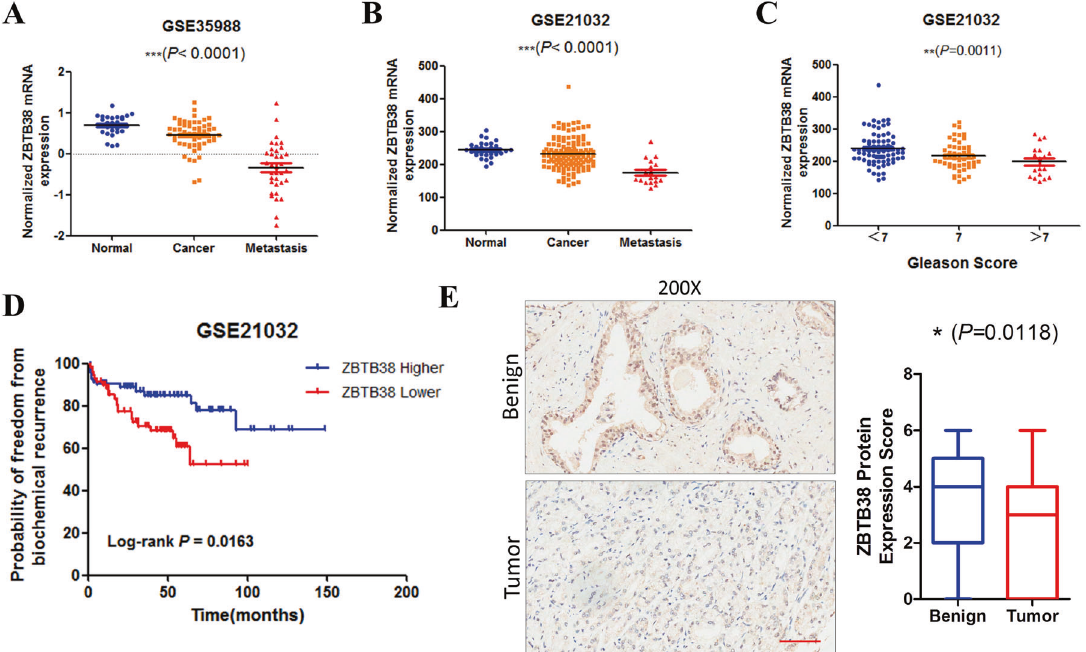
Fig. 1 ZBTB38 expression level correlates with prostate cancer progression and prognosis. A , B ZBTB38 mRNA expression levels in prostate cancer samples from GSE35988 ( A ) and GSE21032 ( B ). One-way ANOVA analysis was used. C ZBTB38 mRNA expression levels in prostate cancer samples with different Gleason Score groups in GSE21032. One-way ANOVA analysis was used. D ZBTB38 mRNA level was associated with prostate cancer prognosis. A statistically signi fi cant increase in RFS was observed in patients with a higher ZBTB38 expression group ( P = 0.0163). E Representative IHC images of ZBTB38 in prostate cancer tissues ( N = 94 in Benign and cancer group, respectively; Scale bar: 100 μ m). (**P < 0.01, ***P <